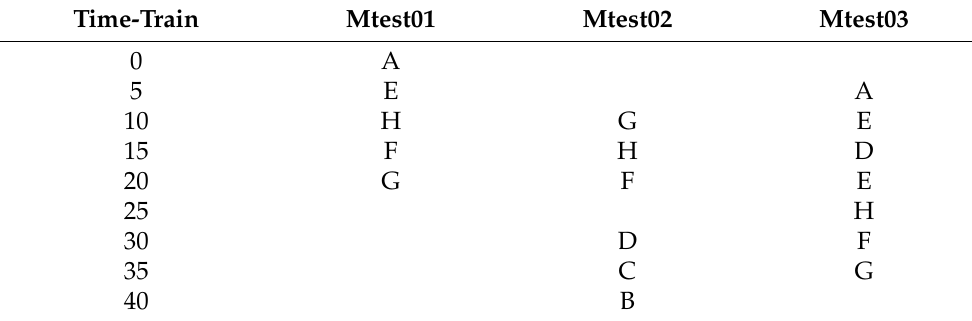
Figure 11. Case 4: Train schedule. Table 8. Case 4: Train